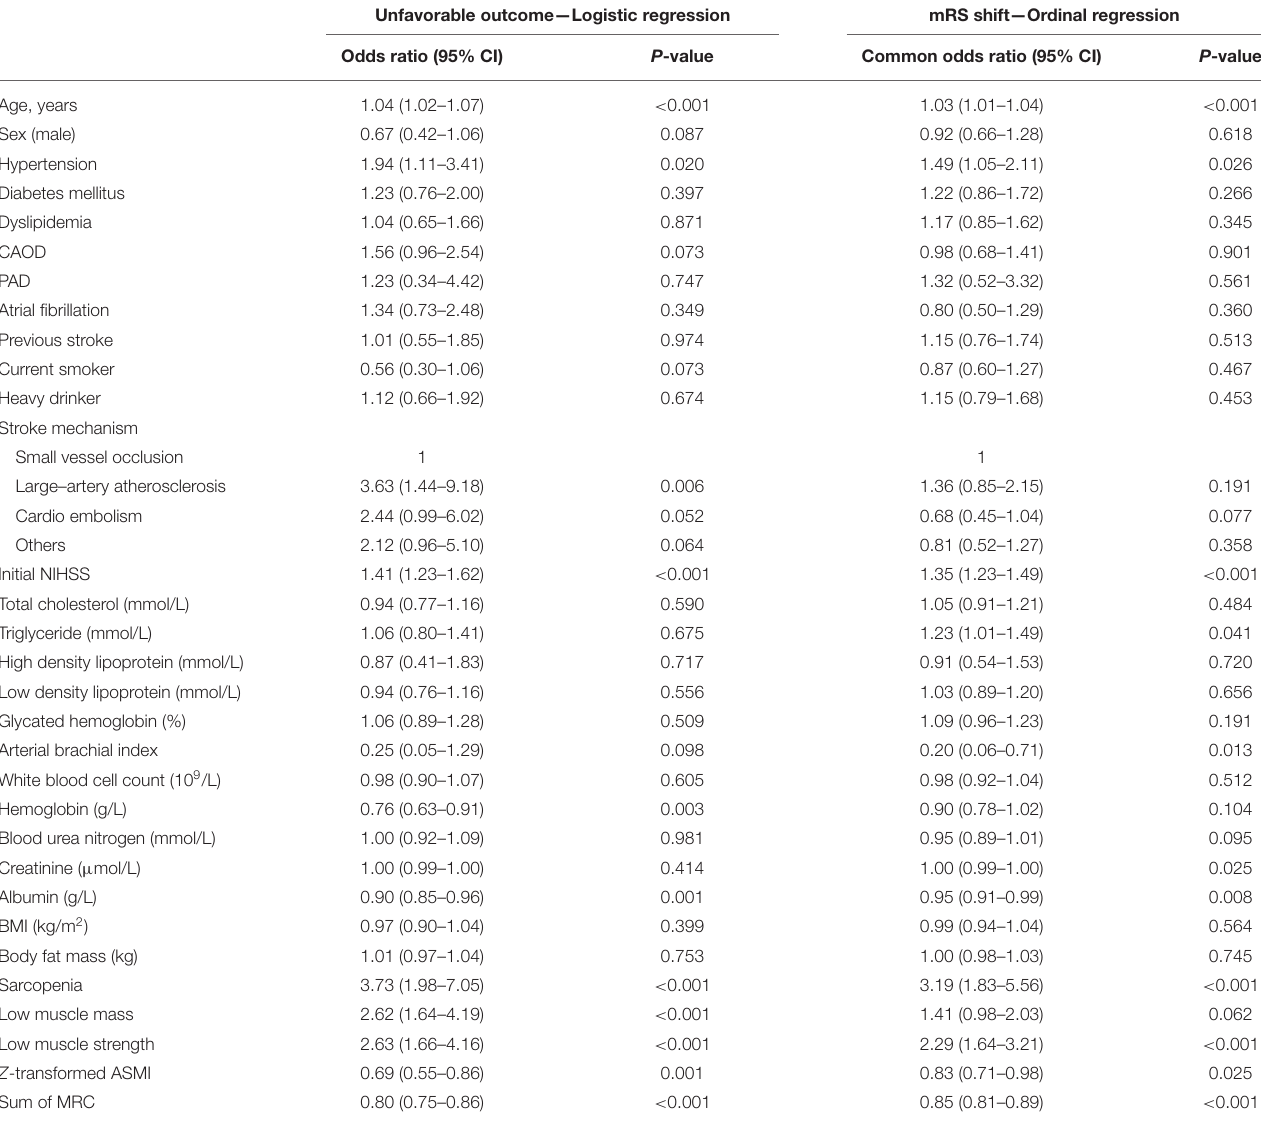
TABLE 2 | Univariable logistic regression analysis and ordinal regression analysis for factors associated with functional outcome 90 days after discharge. Unfavorable outcome—Logistic